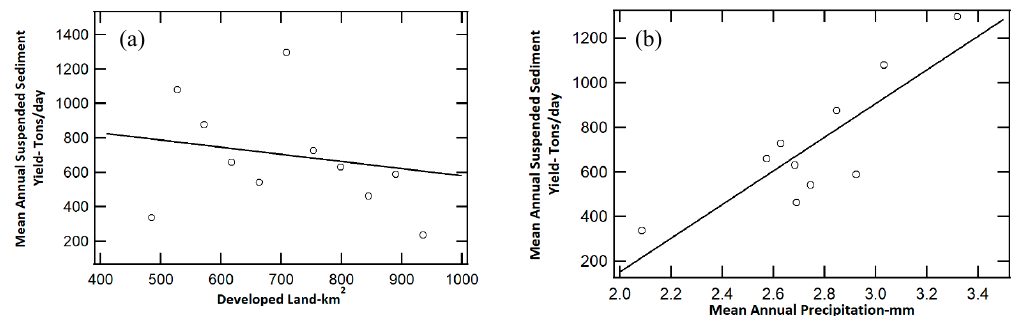
Figure 11. Relationship between ( a ) developed land area and mean annual suspended sediment yield, and ( b ) mean annual precipitation and mean annual suspended sediment yield.